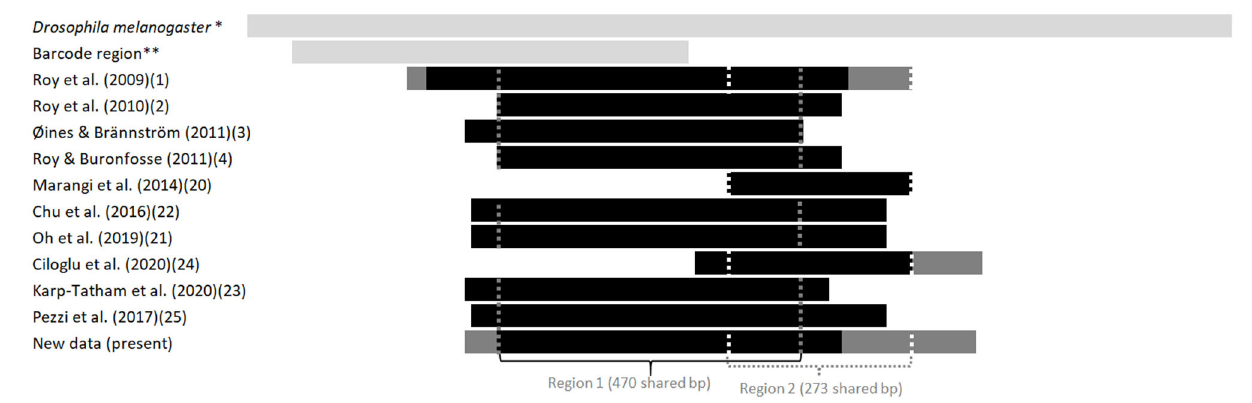
FIGURE 2 | Length and position in relation to the Drosophila ’s full sequence of fragments of the gene coding for CO1 available in the GenBank from various studies on the genus Dermanyssus . The first light gray bar at the top illustrates the sequence length of the complete CDS gene in Drosophila melanogaster , taken as a reference, and the second one shows the length and relative position of the barcoding region. The following bars represent the positions of the sequences studied in relation to this reference sequence. Light gray, reference sequences (from studies not considered here), black, all sequences in a study; dark gray, longest sequences among sequences of various sizes (when a longer fragment has been sequenced in a part of the mites in a study). The vertical dotted lines delimit the sequences used in the two CO1 alignments analyzed in the present study (namely “region 1” and “region 2”). *NCBI Reference Sequence: NC_024511.2. ** Based on the GenBank sequence